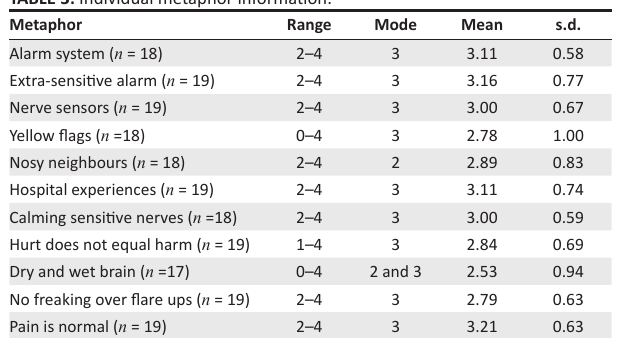
FIGURE 3: Rating of the pain neuroscience education metaphors (0 = cannot remember; 4 = very